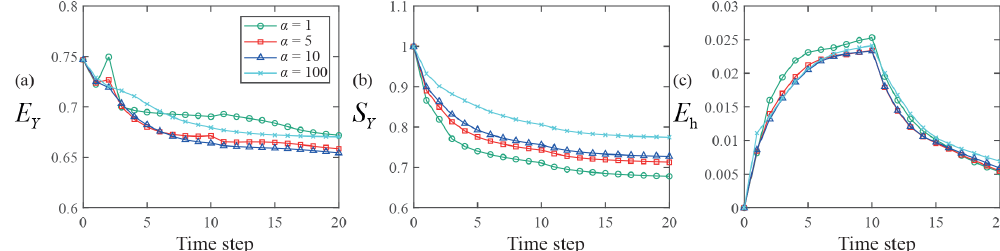
Figure 10. Temporal evolution of E Y (a) , S Y (b) , and E h (c) with α = 1 (TC2), 5 (TC2 α 1 ), 10 (TC2 α 2 ), and 100 (TC2 α 3 ).